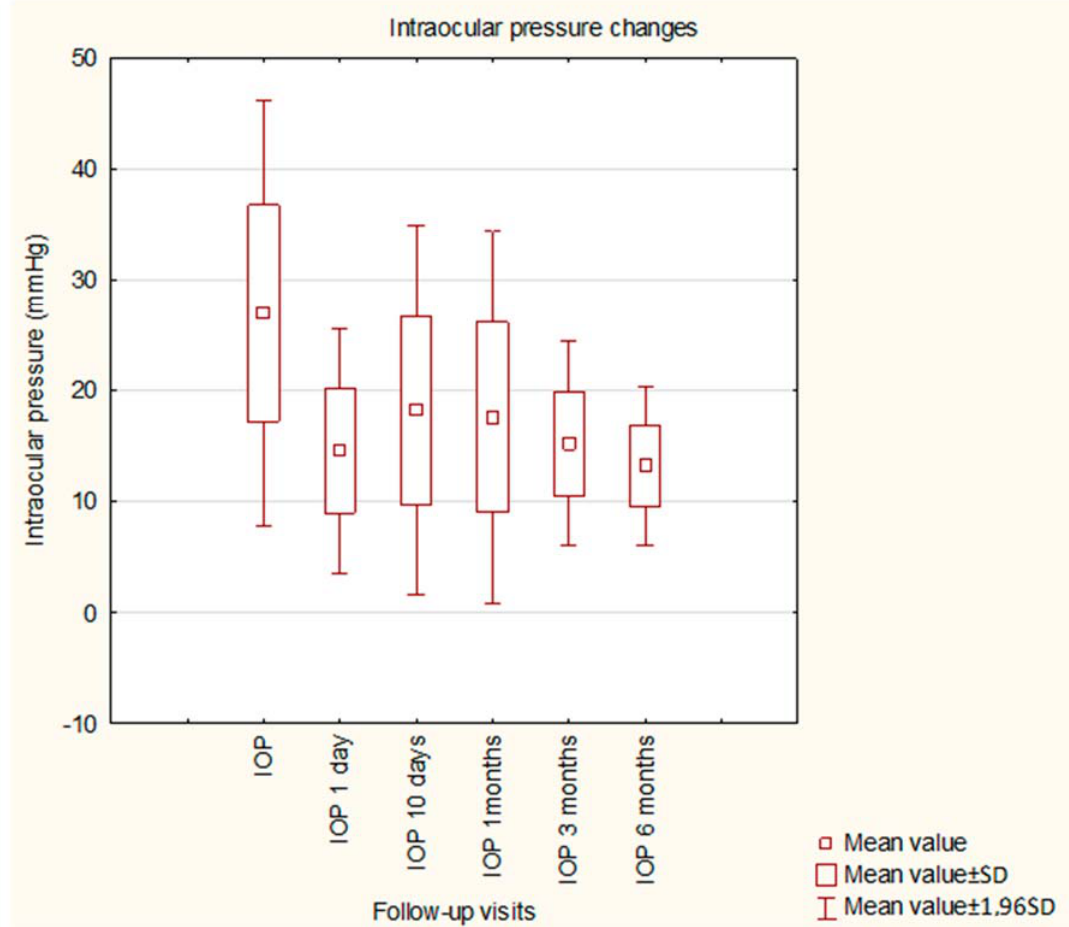
Figure 1. Intraocular pressure changes during the study.